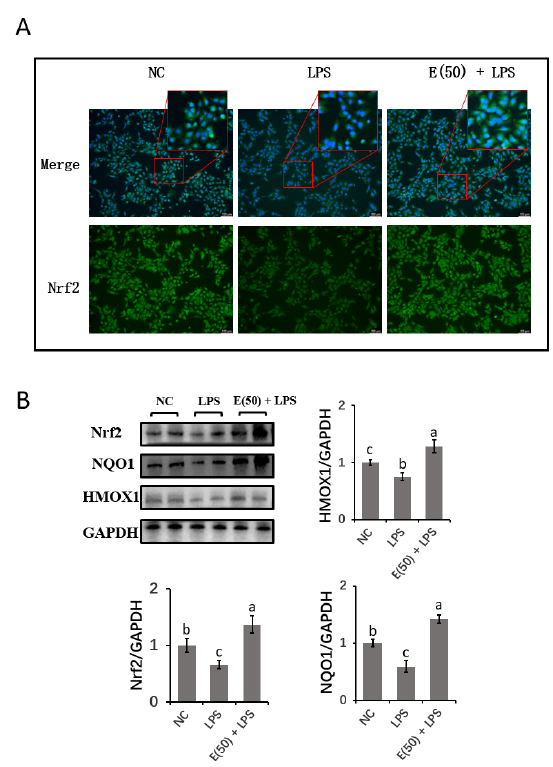
Figure 7. Protein expression of Nrf2 signaling components. The concentration and timing of EGCG treatment to cells were selected as for 24 h at a concentration of 50 µ M. ( A ) Immunofluorescence for detecting the Nrf2 molecules in cells nuclear. The target protein was stained with FICT-labeled secondary antibody (Green), and the DAPI was used for staining nuclear (Blue). Cells were observed at 200 × magnification. ( B ) Nrf2 signaling related proteins were determined using western blot immunoassay. Abundance of each protein was normalized with GAPDH band intensities in corresponding group. Results are expressed as means ± S.E.M. Experiments were performed as three independent replicates. Letters in superscript indicate that the difference between groups was significant ( p < 0.05).